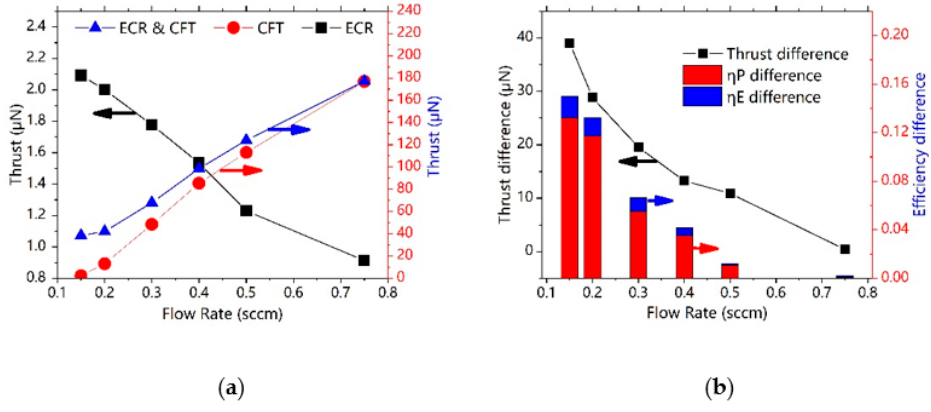
Figure 21. ( a ) Thrust curves of the three modes in a microwave discharge cusped field thruster. ( b ) Thrust difference, propellant utilization difference, and energy efficiency difference between com- bined mode and CFT mode.